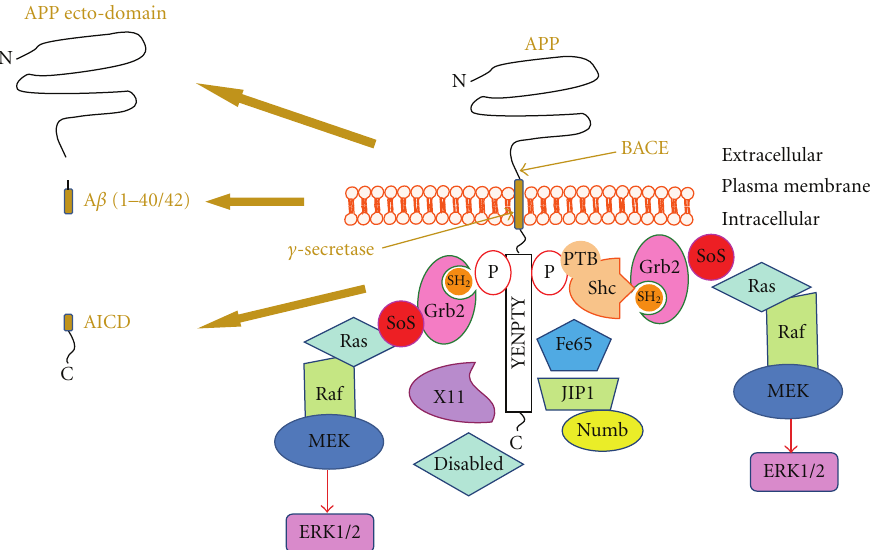
Figure 1: Schematic representation of A β PP processing, the adaptor proteins interacting with its intracellular domain and the pathway leading to ERK1/2 activation. In the left panels is reported the transmembrane protein APP, before and after ITS sequential beta secretase (BACE) and gamma secretase cleavage, with its final products, AICD, APP ectodomain, and beta amyloid peptide (1–40/1–42). In the right part of the figure are indicated the protein interacting with APP intracellular domain, upon or independently from tyrosine phosphorylation. The adaptor proteins Shc and Grb2 through their phosphotyrosine-binding domain (PTB) and src homology domain (SH2) are able to directly bind tyrosine-phosphorylated APP, resulting in the recruitment of the components of the MAP kinase cascade (SoS, ras, Raf, MEK) leading to ERK1/2 activation. Grb2 may participate in this pathway either by direct binding to APP or being recruited by Shc. Alteration in ERK1/2 activity induced in this way may contribute to neurodegeneration in AD. Transduction pathway adaptors (X11, disabled, Fe65, JIP1, and Numb) that bind APP in the absence of tyrosine phosphorylation depicted are also